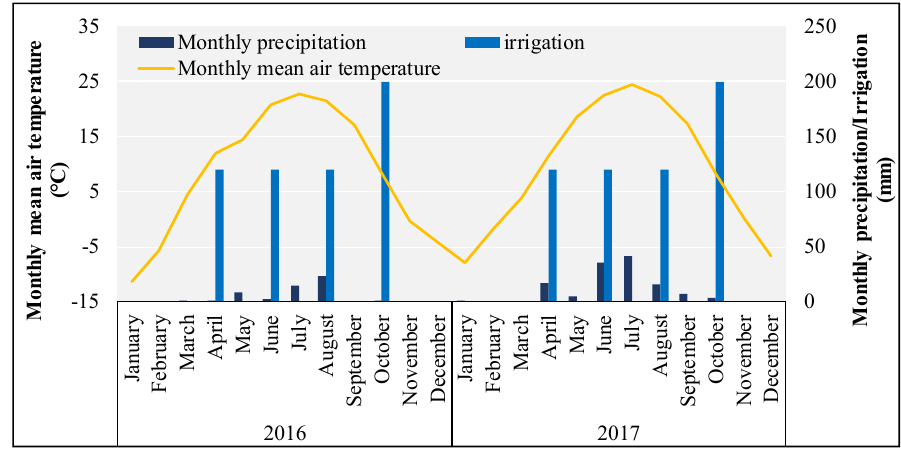
Figure 1. The air temperature, precipitation, and irrigation of study site in 2016 and 2017.